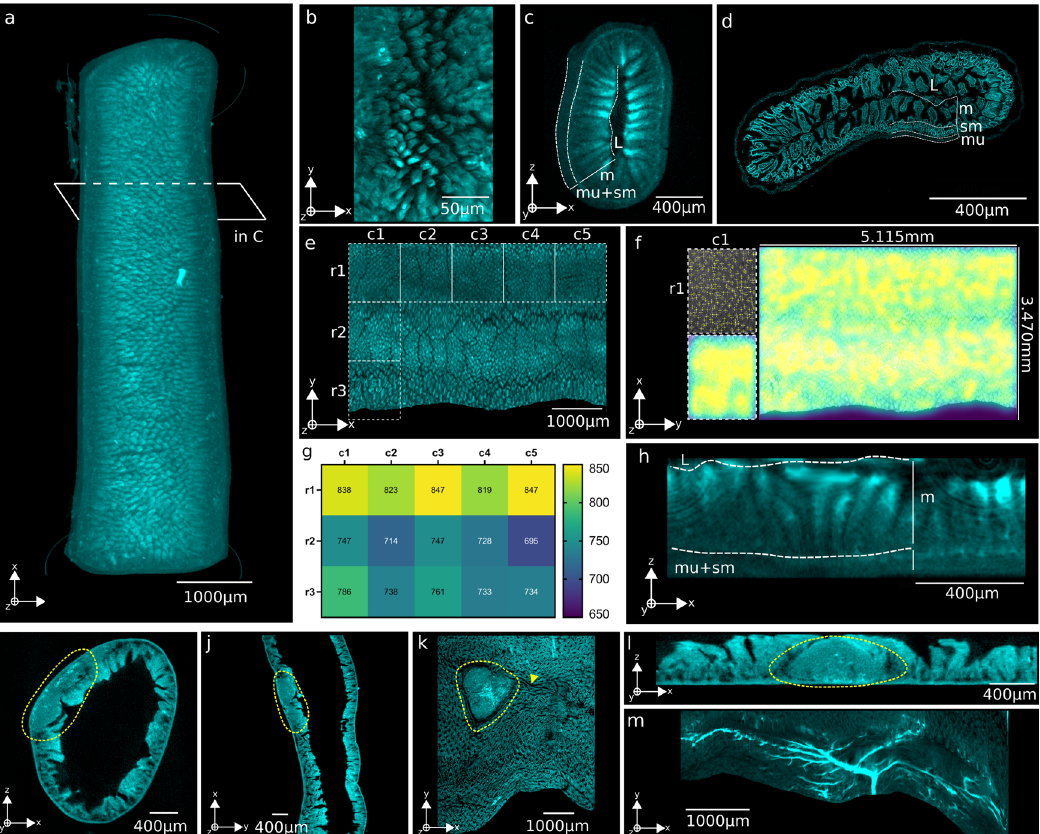
Fig. 2 Label-free visualisation and characterization of the intestine. a Filtered Back Projection reconstruction from a single acquisition of gut in the auto fl uorescence channel. b Close-up of the villi structures from within the lumen. c Cross-sectional view of the 3D reconstruction, with visible layers labelled mu muscularis, sm submucosa, m mucosa and L lumen. d High-resolution tiled acquisition of the same gut sample using confocal microscopy, with concurrent layers labelled. e Innermost layer of the same reconstruction that was virtually unfolded 28 . f Unfolded image and whole gut segment quanti fi cation of villous density by Laplacian fi lter and the function fi nd maxima . g Villous density quanti fi ed within sub-regions of the unfolded scan. h Cross-sectional view of unfolded image, with mucosal layers labelled as in c . i – m Images of tertiary lymphoid structures encircled in yellow from a cross- section view ( i , j ) or top to bottom ( l ). k Unfolded image reveals tri-lobular structure and possible vascularisation (arrow). l Straightened cross section of structure in i . m Widespread network of large vessels in an unfolded